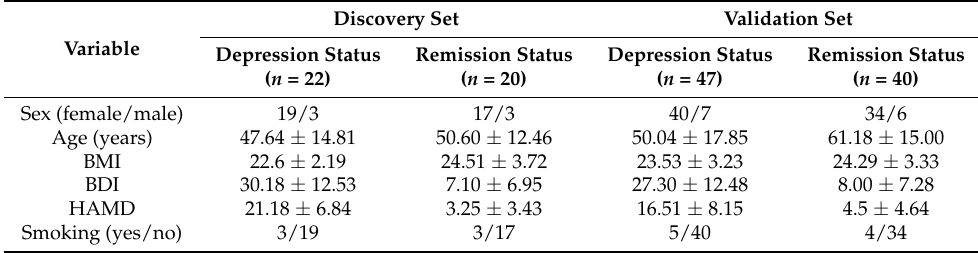
Table 1. Study subject